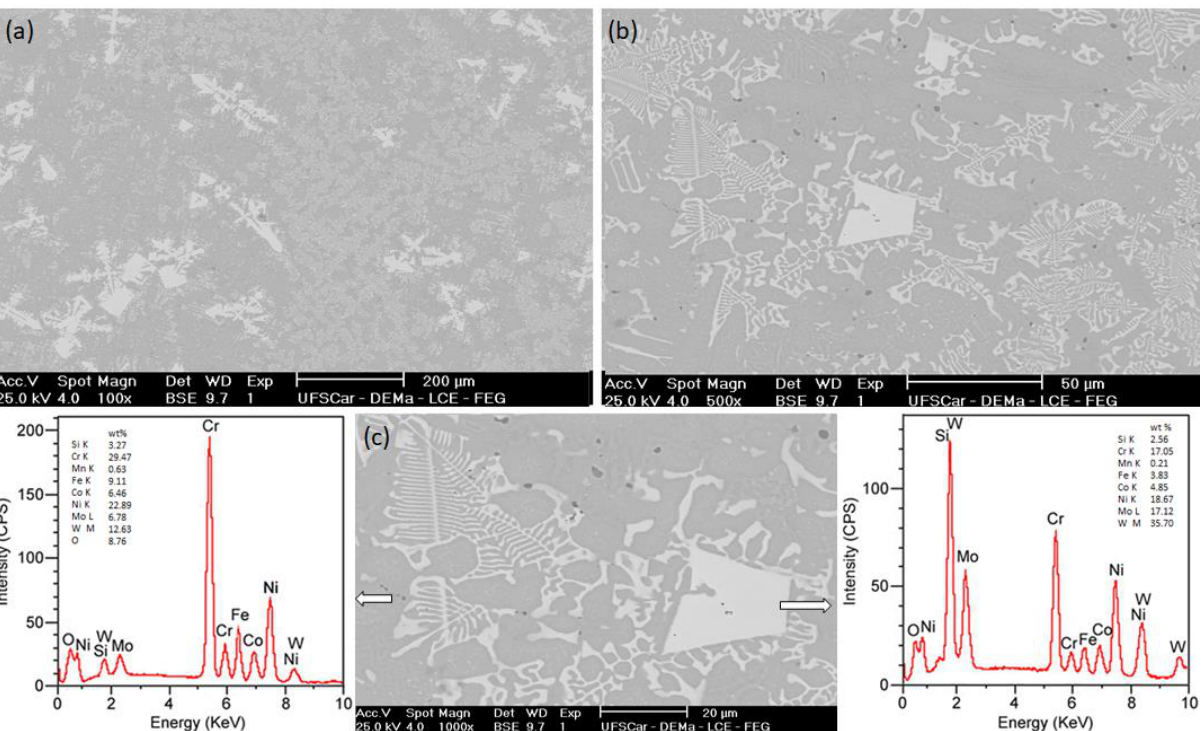
Figure 3. BSE SEM micrographs of the Ni-based alloy: ( a , b ) chemical contrast of the microstructure; and ( c ) EDS spectra of the different phases.